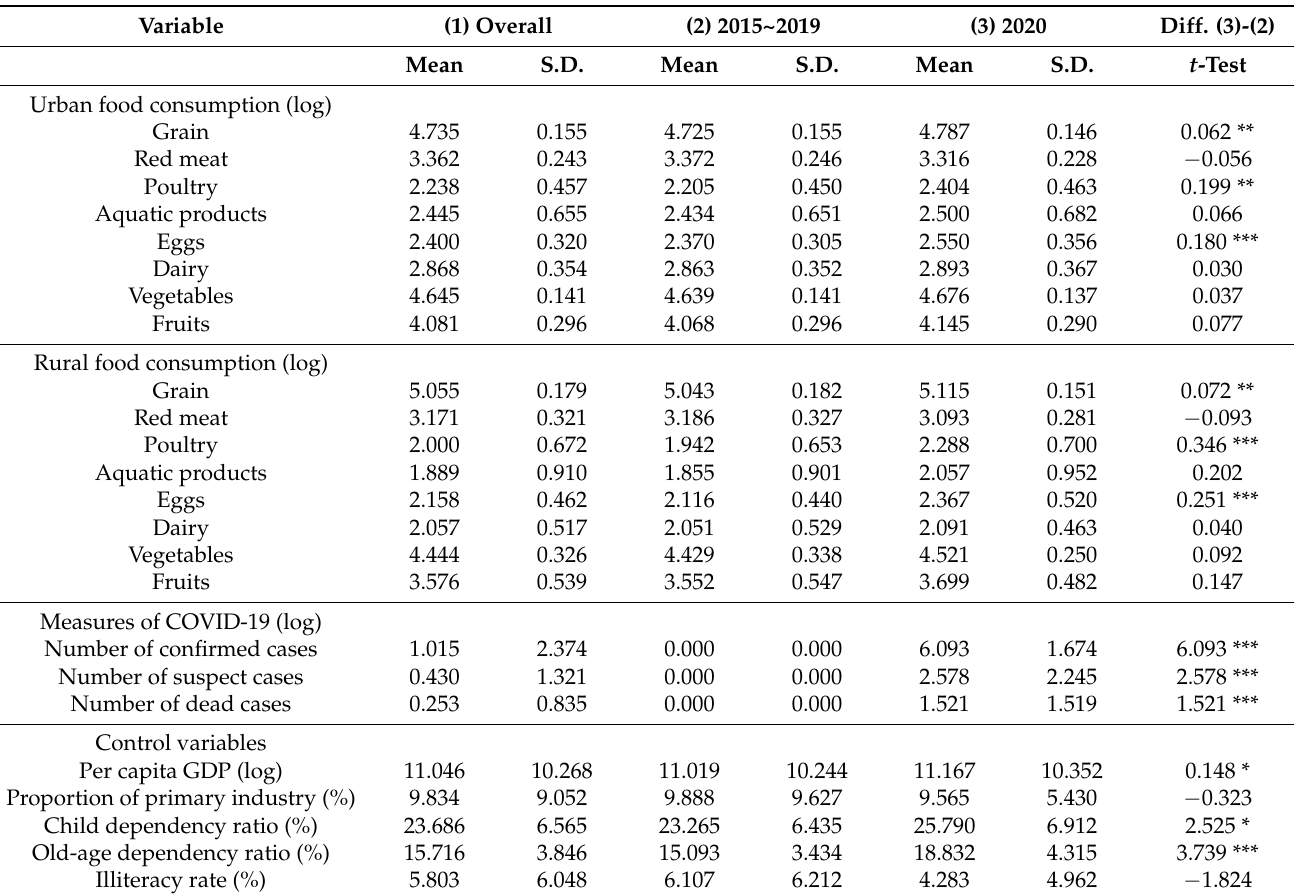
Table 1. Descriptive